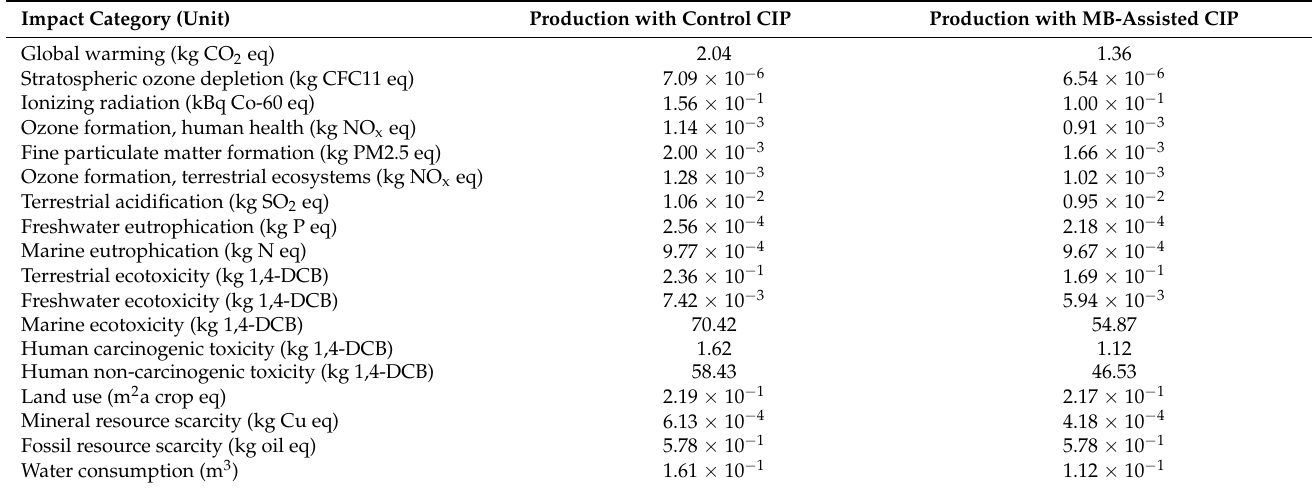
Table 4. Environmental impacts of simplified concentrated milk production including control or MB-assisted CIP